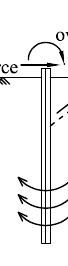
Figure 14. Schematic representation of the soil-failure mechanisms for laterally loaded piles.